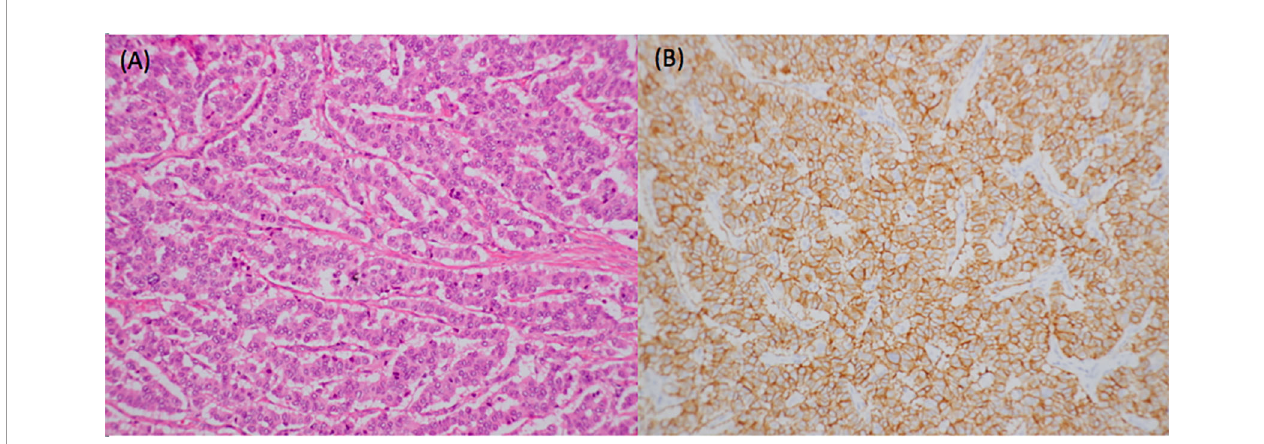
FIGURE 4 | Pathology from distal pancreatectomy showed a neuroendocrine tumor with numerous mitotic fi gures (A) . Immunohistochemical analysis revealed that tumor cells were all positive for CD56, chromogranin A, synaptophysin, and beta-catenin on the membrane but negative for insulin. Ki-67 index was 15%. Therefore, it was a grade 2 neuroendocrine tumor (B) .